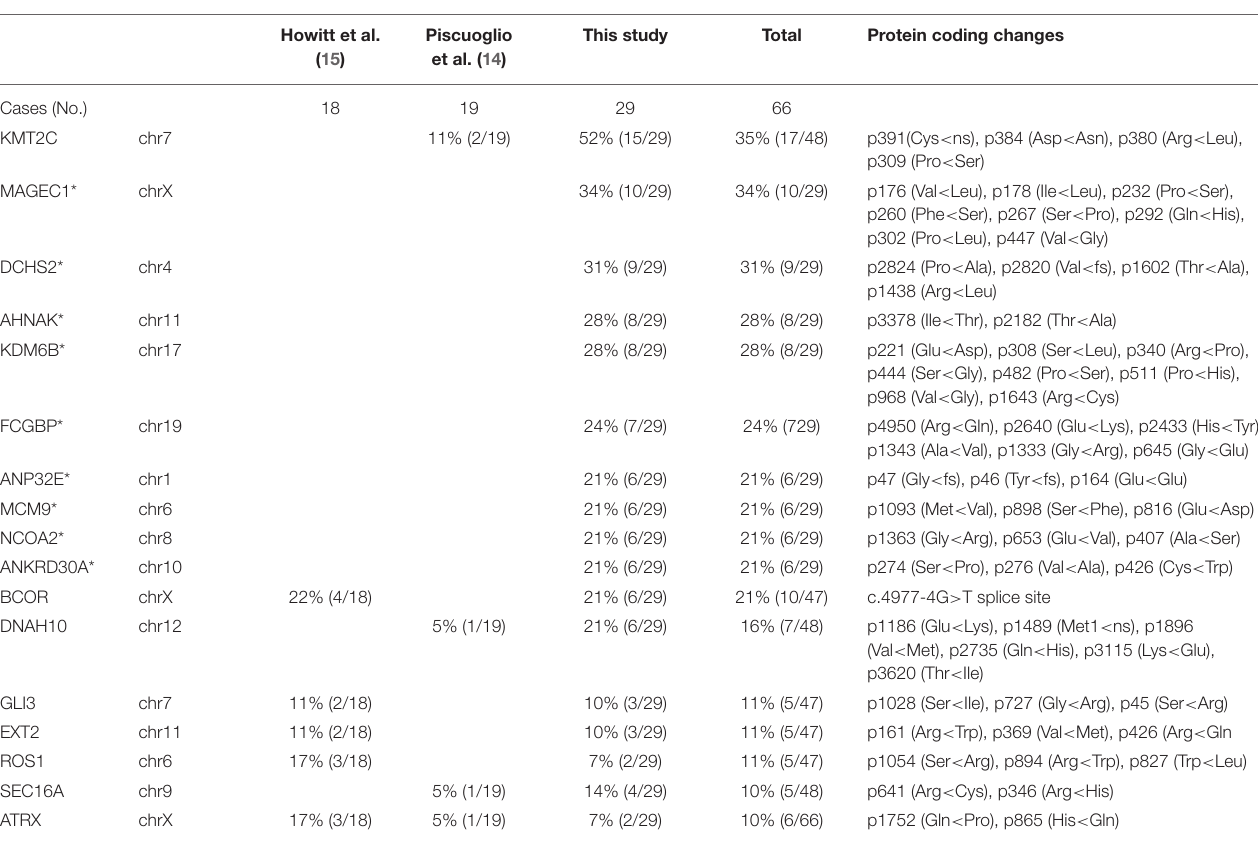
TABLE 2B | Frequently mutated genes in MAS.